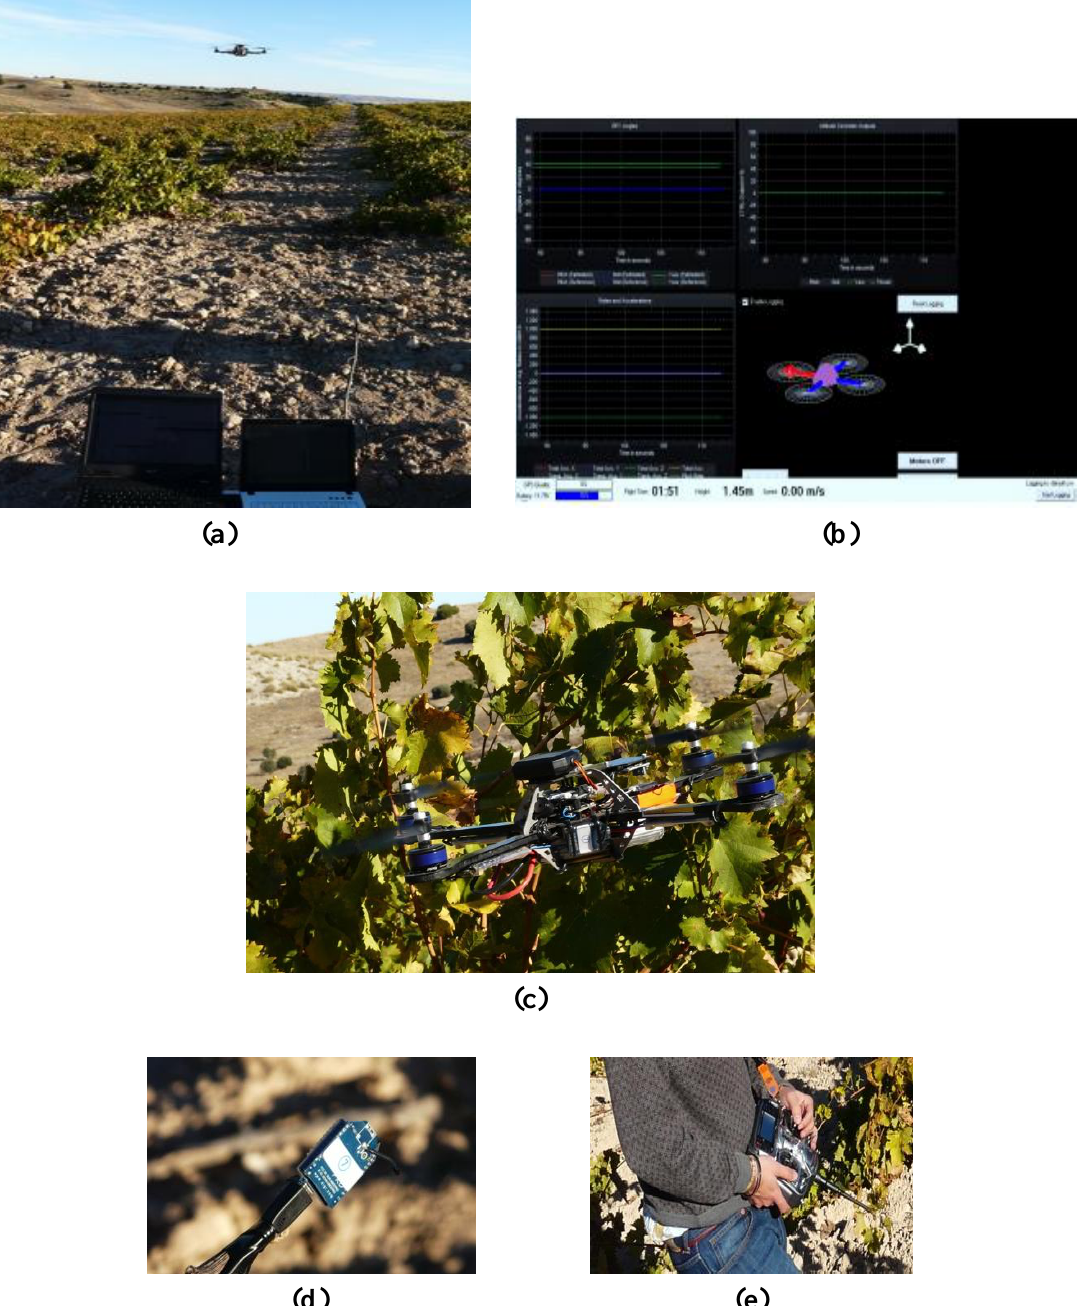
Figure 6. Aerial vehicle experimental setup. (a) Mobile base-station, (b) Quadrotor graphical operator interface, (c) Quadrotor, (d) Data link, (e) Emergency pilot remote control